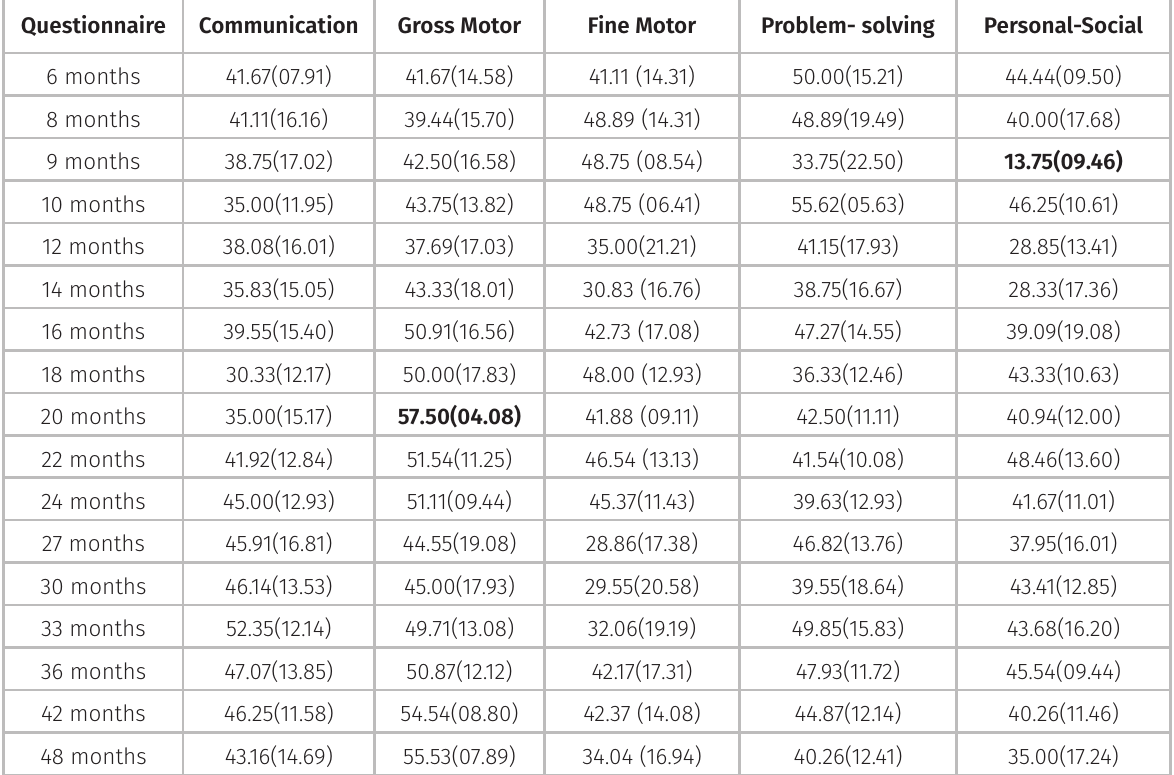
Table I. Mean and standard deviation (deviation in parentheses) of the scores obtained in each domain, divided by